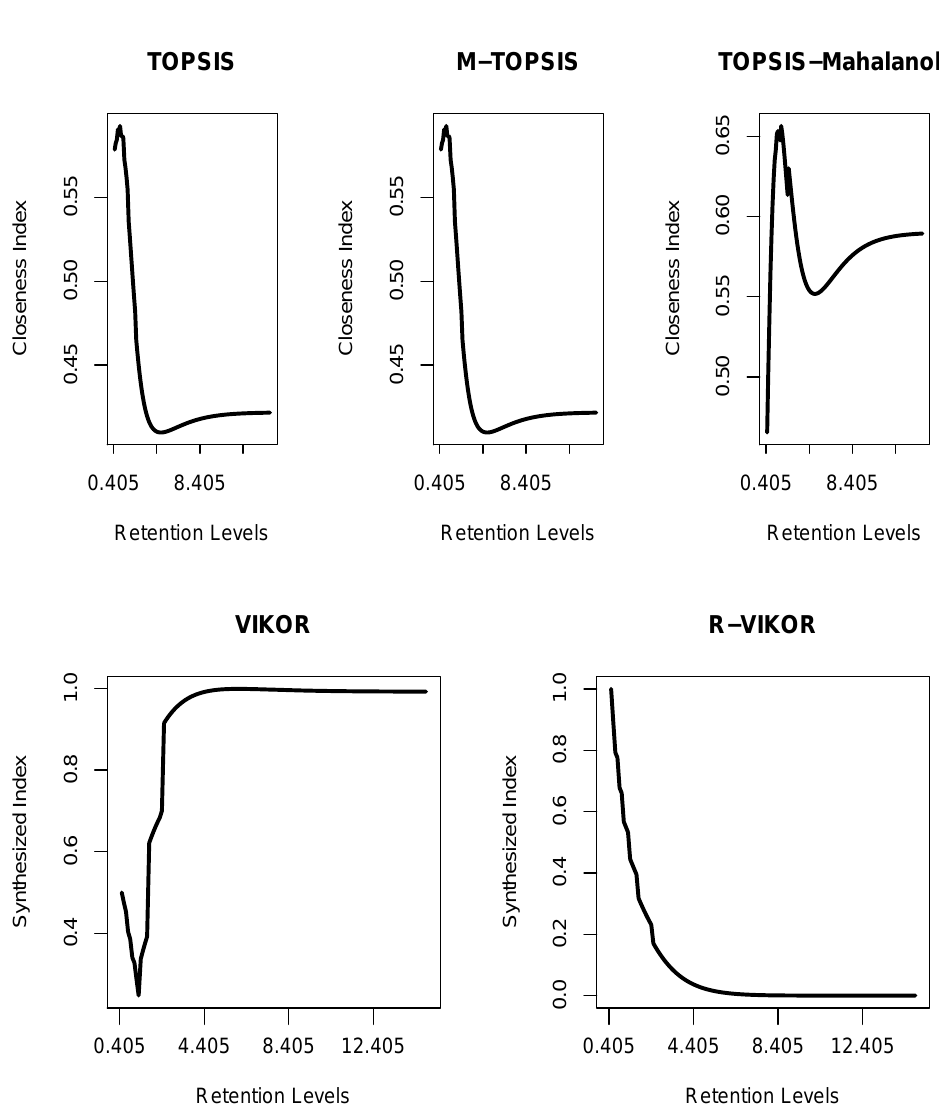
Figure 2. Comparison of rankings under the standard deviation premium principle when u = 5 and t =